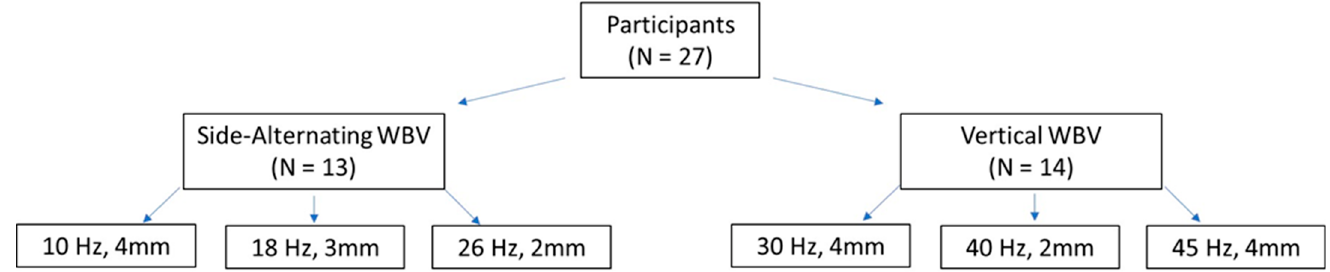
Figure 1. Study Design. Note: Hz, hertz; mm, millimeters; WBV, whole body vibration; the terms horizontal and side-alternating are used interchangeably in the literature.